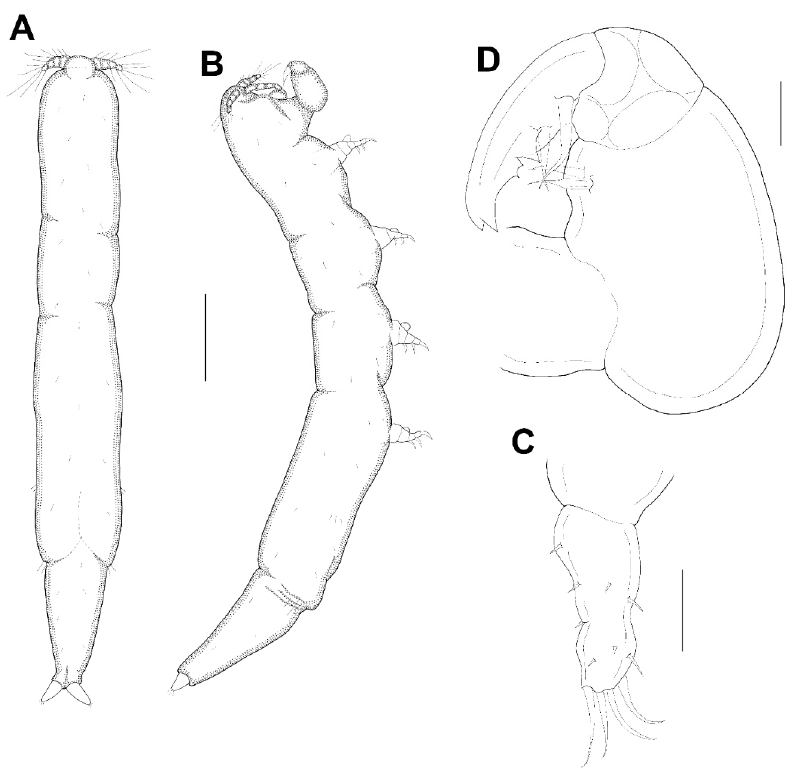
Figure 10. Xarifia magnifica sp. nov. male. Habitus, dorsal ( A ); habitus, lateral ( B ); caudal ramus ( C ); maxilliped ( D ). Scale bars: ( A , B ) = 0.25 mm; ( C , D ) = 0.025 mm. The appendages including antennule, antenna, mandible, maxillule, and maxilla as that of female, but antennule with additional aesthetasc indicated by a dot on second seg- ment (Figure 7E). Maxilliped (Figure 10D) 4-segmented; syncoxa (first segment) and first endopodal segment (third segment) unarmed; basis (second segment) largest, with 2 me- dial setae (one normal and one modified with sclerotized base and hyaline attenuate distal part); second endopodal segment (fourth segment) a claw with bifurcate tip, bearing with 2 proximal setae equally; concave margin with 3 serrations. Legs 1–4 as in female; leg 5 (Figure 10B) consisting only of 3 setae. Leg 6 (Figure 10A, B) represented by 2 small setae on the genital operculum of genital somite. Spermatophore not observed. Etymology: The specific name magnifica , Latin adjective for “big” or “majestic” refers to the relatively strong element on the third segment of maxilliped. 4. Discussion Based on the findings from this study, the genus Xarifia currently consists of 94 spe- cies and eight of them live in association with the Psammocora coral. The armature of en- dopods of legs 1–4 is the main diagnostic feature of Xarifia . The terminal segment of en- dopods of legs 1–4 of X . yanliaoensis sp. nov. is a unique character, armed with 1, 2, 0, 1 setae, respectively. After comparison with another valid species of Xarifia , we recognized that only Xarifia simplex Humes, 1985 [4] parasitic in the Scapophyllia cylindrica (= Merulina cylindrica (Milne Edwards and Haime, 1849) [17]) present the same armature of endopods of legs 1–4. However, the body surface of X . simplex covered with scattered small hairs (setules), while the body surface of X . yanliaoensis sp. nov. is smooth. The X . yanliaoensis sp. nov. differs from X . simplex by (1) the armature formula of the maxilla: three setae in